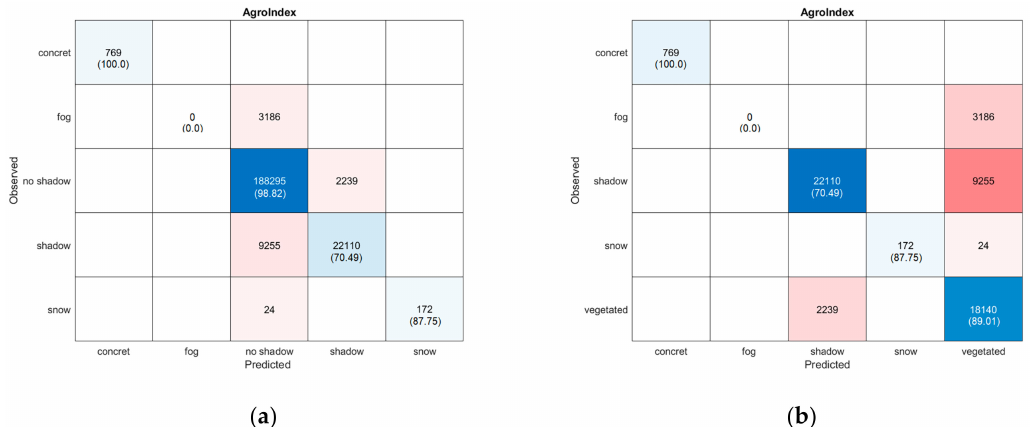
Figure 2. AgroShadow classification rates. Numbers without brackets represent the pixels for each class; numbers in brackets are the recall, in percentages. ( a ) The confusion matrix considers all the pixels, including areas to test bright land covers (i.e., snow and concrete ) and fields covered by light fog ; ( b ) the matrix analyzes particular soil conditions, i.e., flooded rice fields and foggy alluvial plains where AgroShadow makes more misclassifications. Colors refer to the probability of true (blue)/false (red) prediction normalized by the total number of